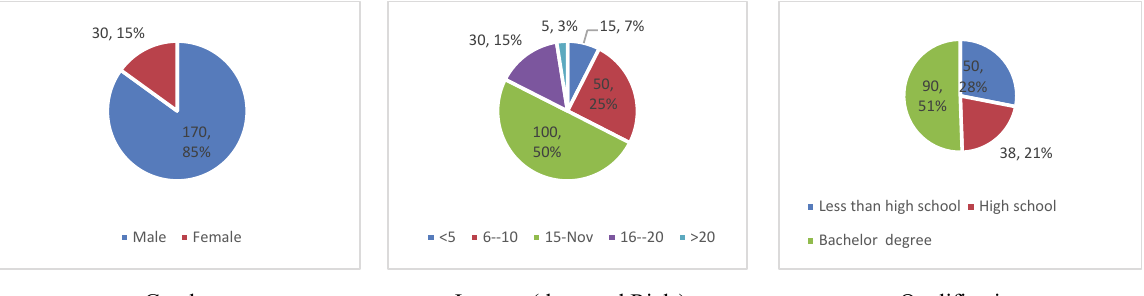
Fig. 1. Demographic characteristics of the study